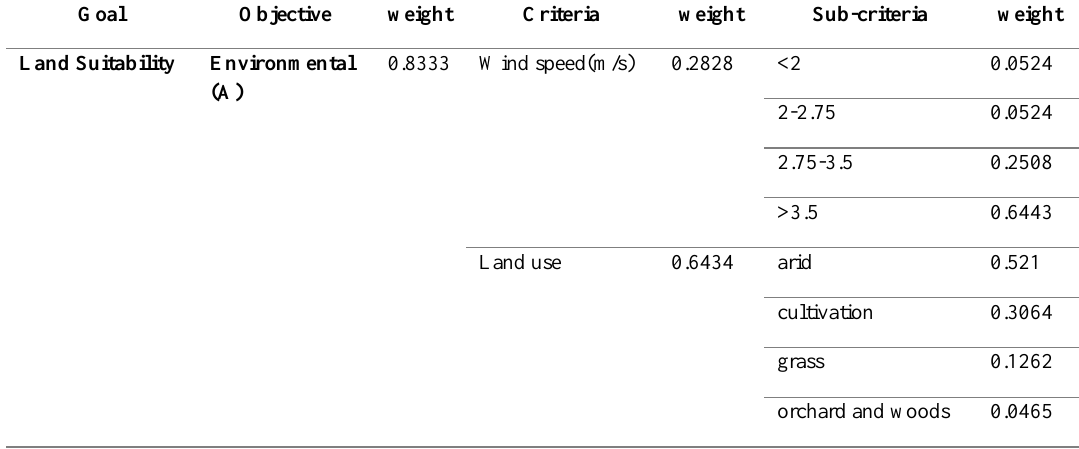
Table 3. Environmental objective for wind turbine site selection